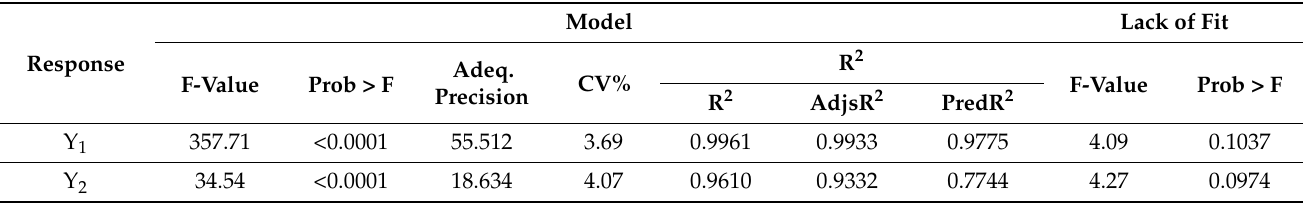
Table 4. Model summary statistics of the response surface